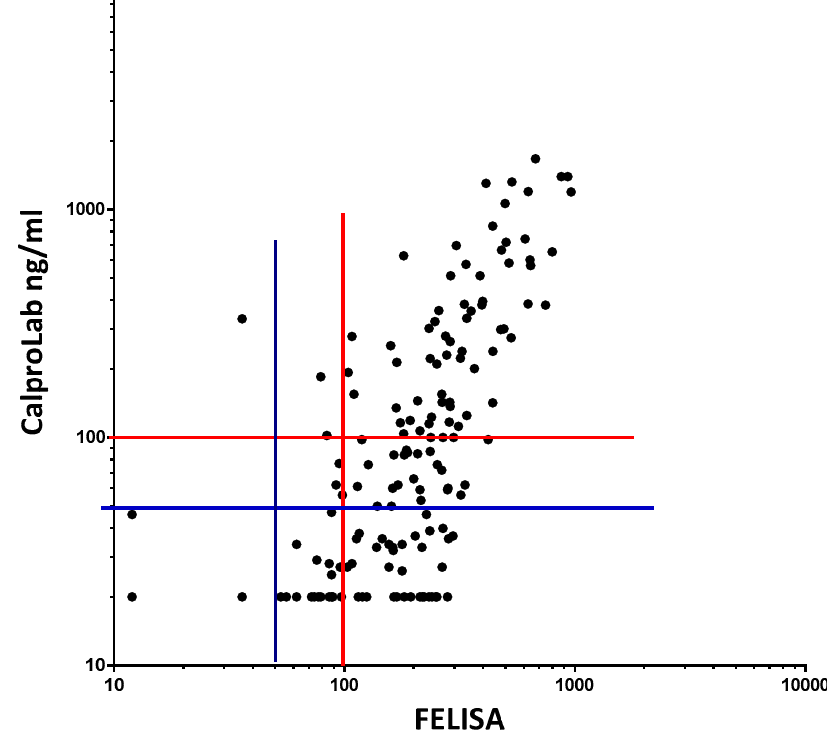
Figure 11. Fecal extracts from IBD patients gave roughly similar values on a commercial CP and on the FELISA, but the former gave lower values, particularly in the low concentration region. The correlation equation is Y = 1.353*X − 129.5, which means that the FELISA has a higher analytical sensitivity, particularly at and below commonly used cut-off levels. Most samples giving normal values (below cut-off levels at 50 or 100 mg/kg) by the CalproLab method had increased levels by the FELISA assay.